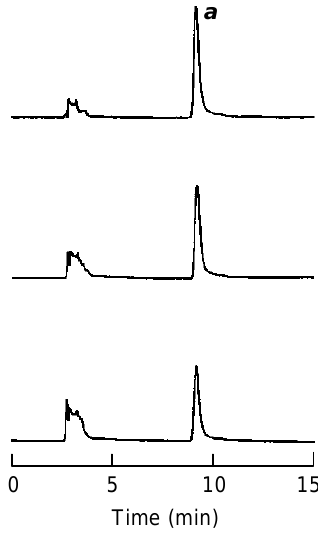
Figure 2 . HPLC analysis of the reaction medium with 100 µM of galangin ( 11 ) and tyrosinase in presence of 0.5 mM L -DOPA. Sampling time was chosen at 0 min (upper), 5 min (middle), and 20 min (lower), respectively. The HPLC operating condition were as follows: column; Capcell Pak C-18 (Shiseido, Tokyo, Japan), solvent; 40 % MeCN/H containing 0.1 % TFA, flow rate; 0.8 mL/min, detection; UV at 280 nm, injected amount; 20 µL from 3-mL assay